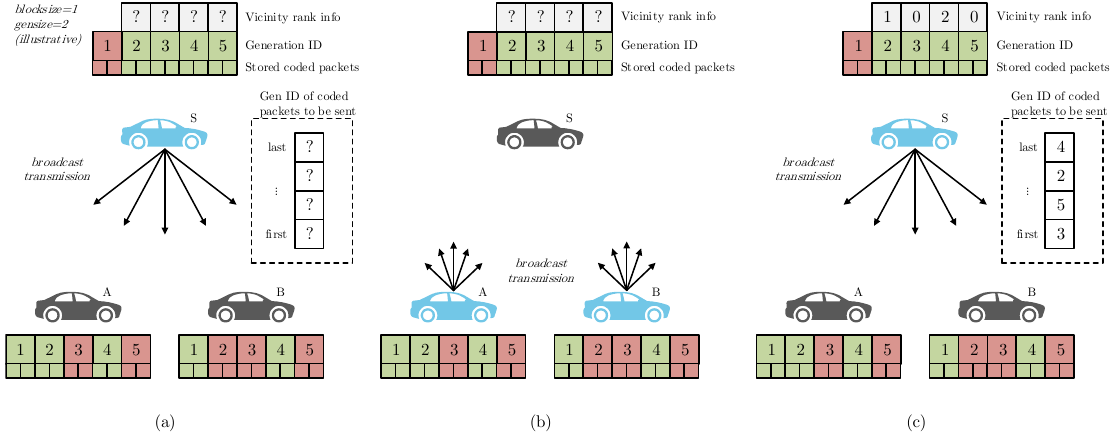
Figure 4. LRGF strategy ( a ) As-Is, ( b ) intermediate, and ( c ) To-Be